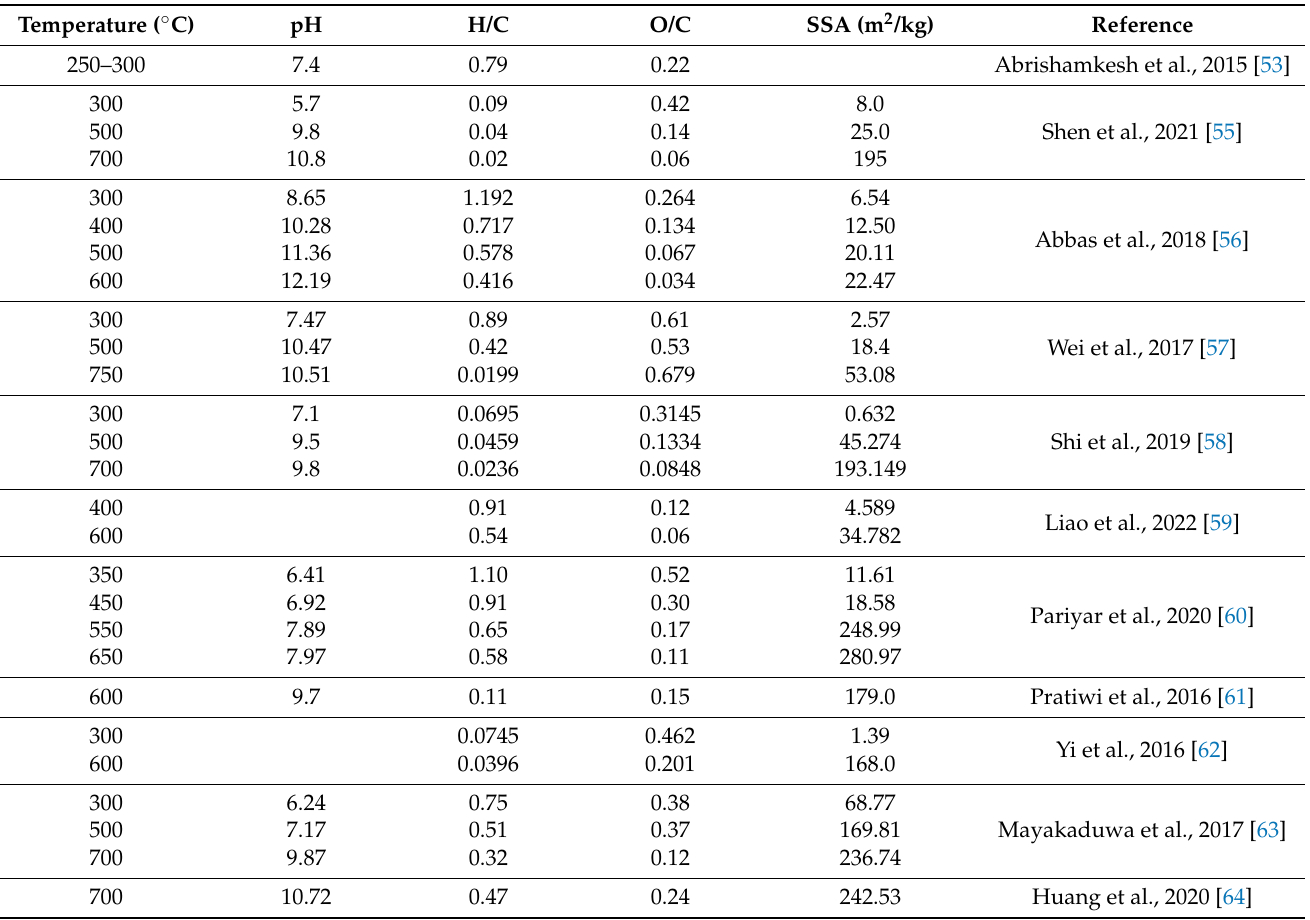
Table 2. Characteristics of rice husk biochar at different pyrolysis